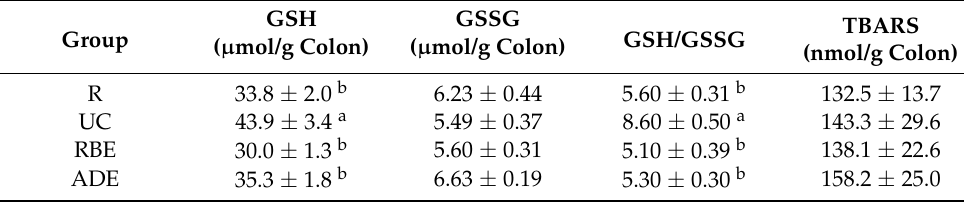
Table 5. Levels of reduced and oxidized glutathione and TBARS in the colon.